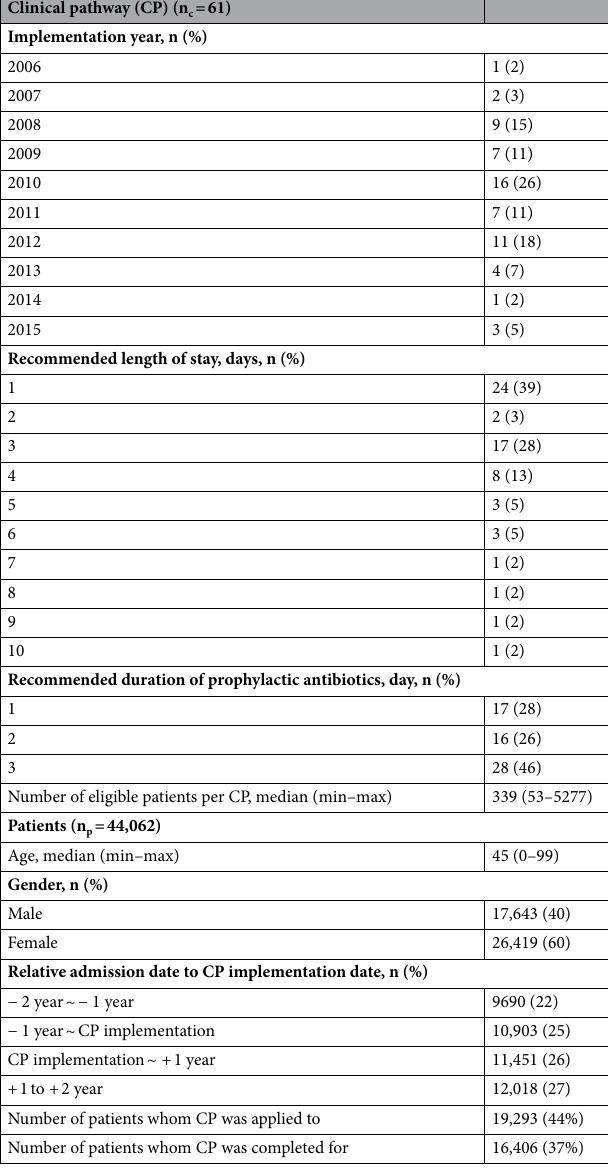
Table 1. Characteristics of the clinical pathway and patients.